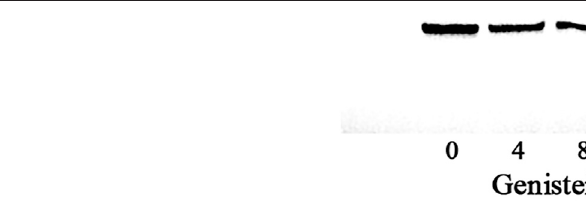
Frontiers in Pharmacology |